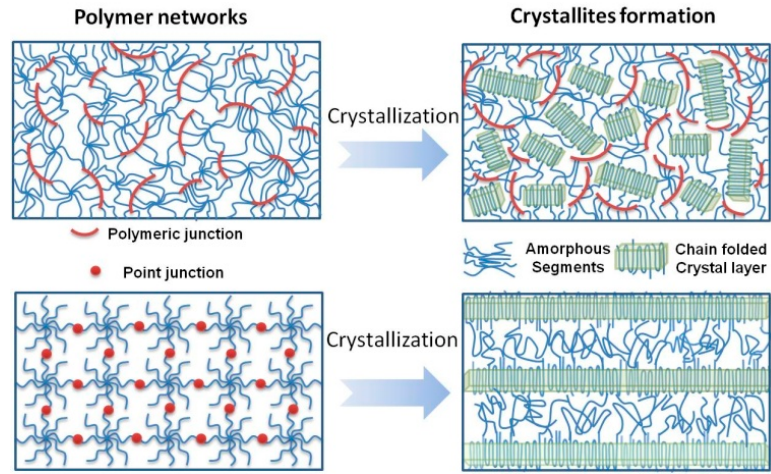
Figure 5. Schematic depiction of the proposed distinct crystallization structures at the supramolecular scale that reside from the two different types of gel network structure.